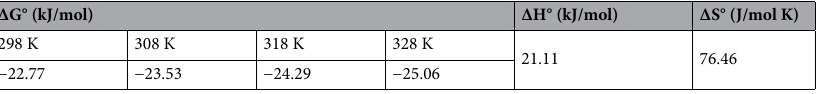
Table 1. Thermodynamic parameters of the adsorption of TC onto MIL-125(Ti)/MIL-53 (Fe) binary MOF/ CNT@Alg composite